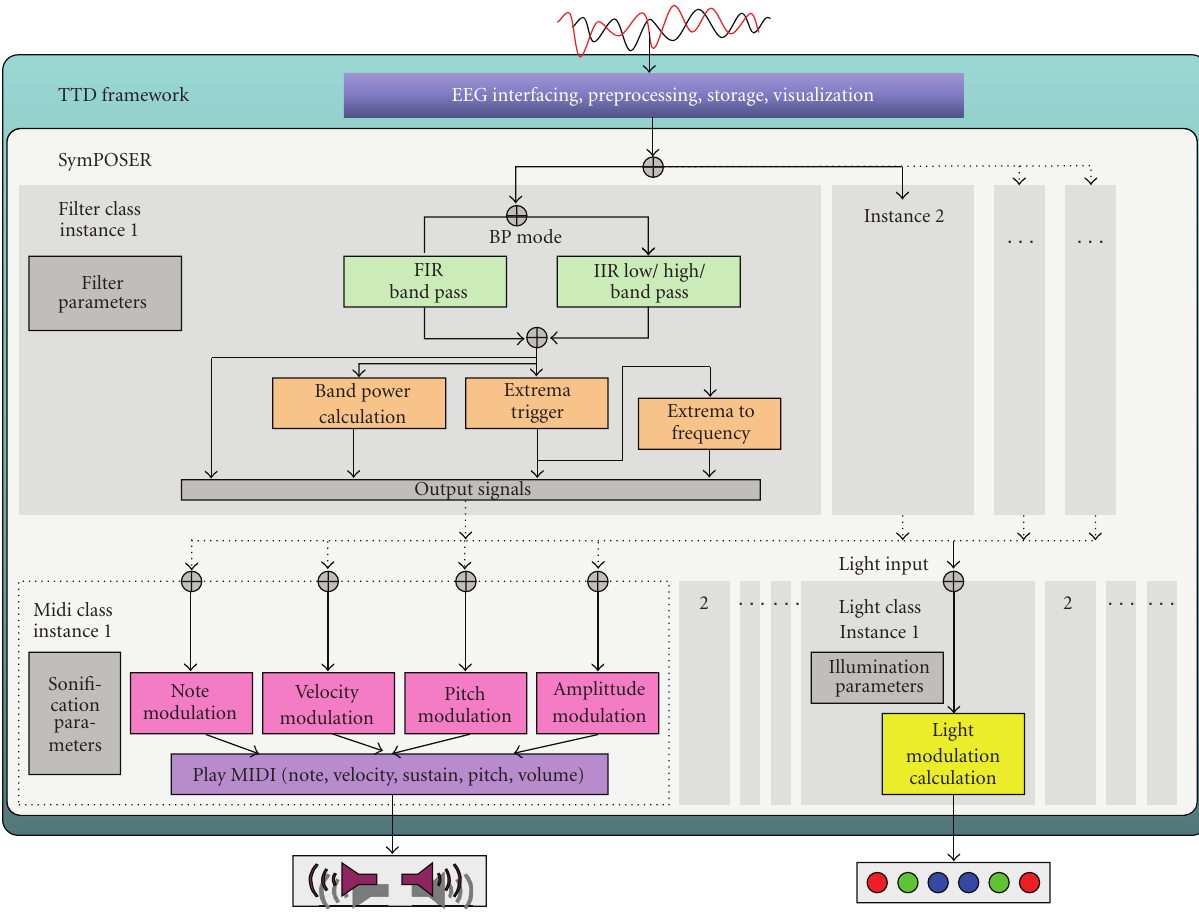
Figure 1: Block diagram and structure of the SymPOSER module. The SymPOSER framework contains instances of the three classes, a filter class, a Midi class for sonification, and a light control class. Each instance of the filter class provides the filtered signals for sonification or light control. Each Midi instance can sonify one EEG component that is played by a specific instrument.